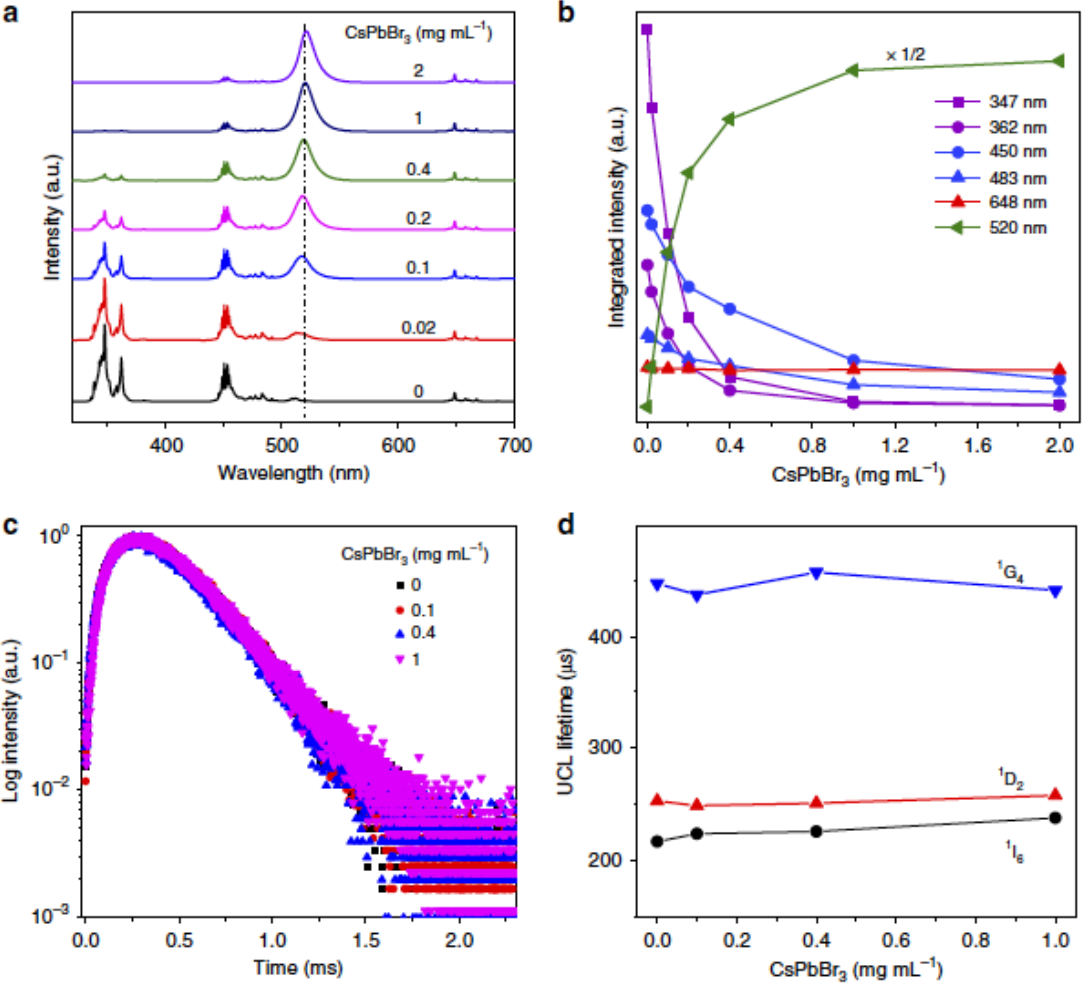
Figure 5. Investigation on the RET process in NP-sensitized CsPbX 3 perovskite NCs. ( a ) CsPbBr 3 concentration-dependent UCL spectra for LiYbF 4 :0.5%Tm 3+ @LiYF4 core/shell NP (1 mg · mL − 1 )-sensitized CsPbBr 3 perovskite NCs excited at 980 nm; ( b ) integrated intensities for Tm 3+ emissions and CsPbBr 3 emission at 520 nm vs. the CsPbBr 3 concentration from ( a ); ( c ) UCL decays from 1 D 2 of Tm 3+ by monitoring the Tm 3+ emission at 362 nm in NP-sensitized CsPbBr 3 perovskite NCs with various concentrations excited at 980 nm; ( d ) UCL lifetimes of 1 I 6 , 1 D 2 and 1 G 4 of Tm 3+ in NP-sensitized CsPbBr 3 perovskite NCs vs. the CsPbBr 3 concentration. Reprinted with permission [74]. Copyright 2018, Nature Publishing.